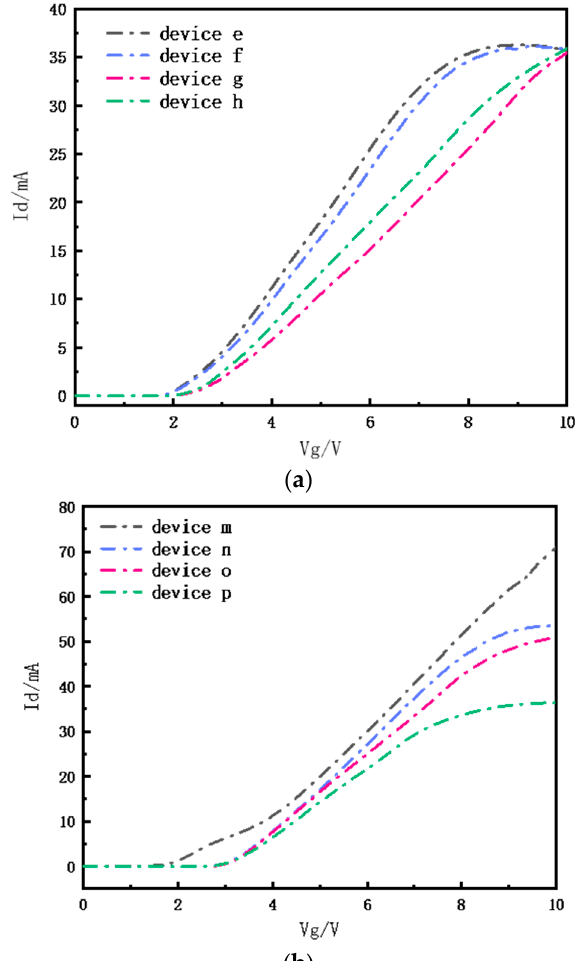
Figure 8. ( a ) Transfer characteristic curve of conventional structure HEMT when Lg = 3/4/5/6 μ m. ( b ) Transfer characteristic curve of ring-gate structure HEMT when Lg = 3/4/5/6 μ m.